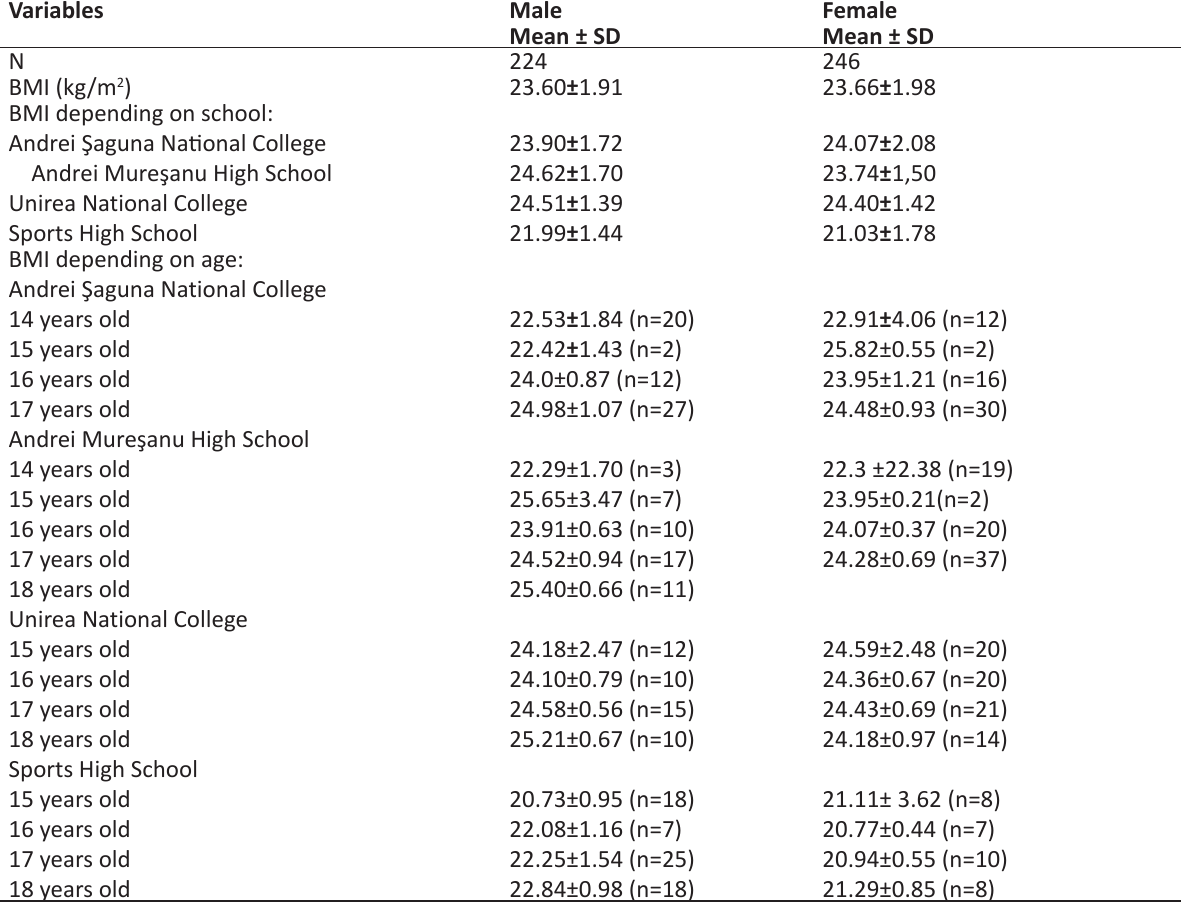
Table 1. Descriptive statistics of the participants Variables